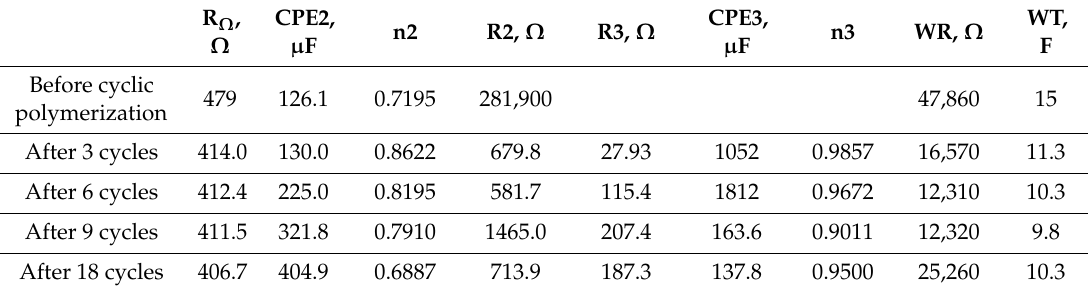
Table 1. Graphite rod electrode under various polymerization steps in polymerization